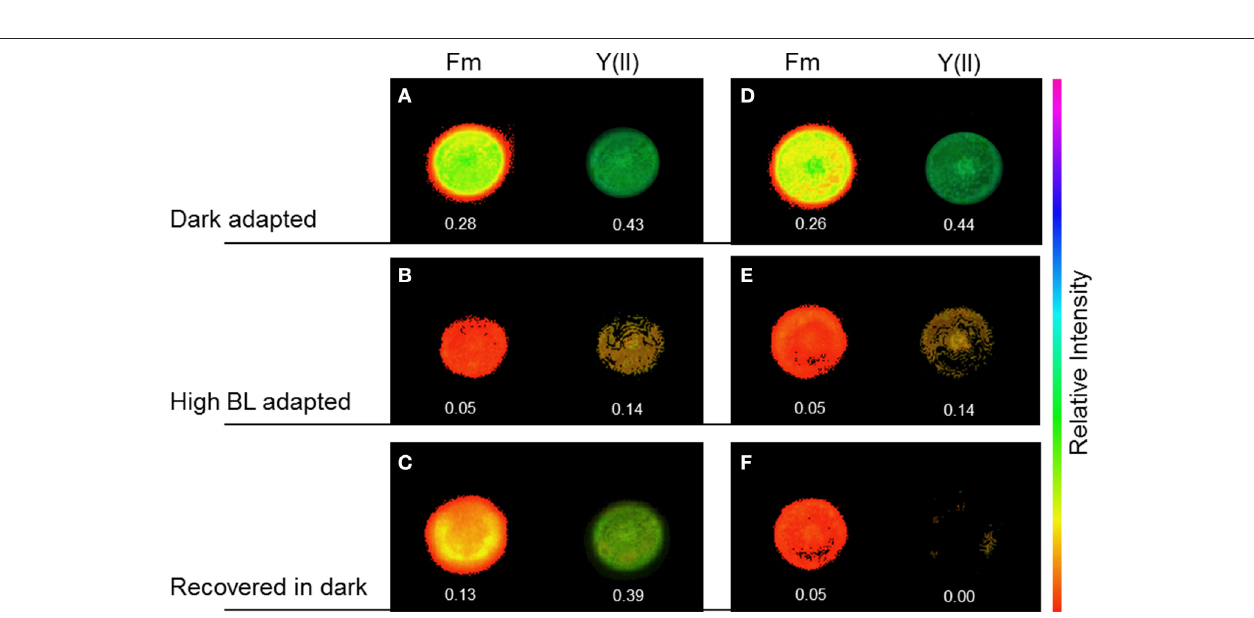
FIGURE 5 | Variable chlorophyll fluorescence in cells of Coscinodiscus granii showing an even chloroplast distribution (ECD) or an altered chloroplast distribution (ACD) after exposure to high blue light (A) and after recovery in the dark (B). Statistically significant differences between the treatments are indicated as different small letters ( p < 0.05 ).